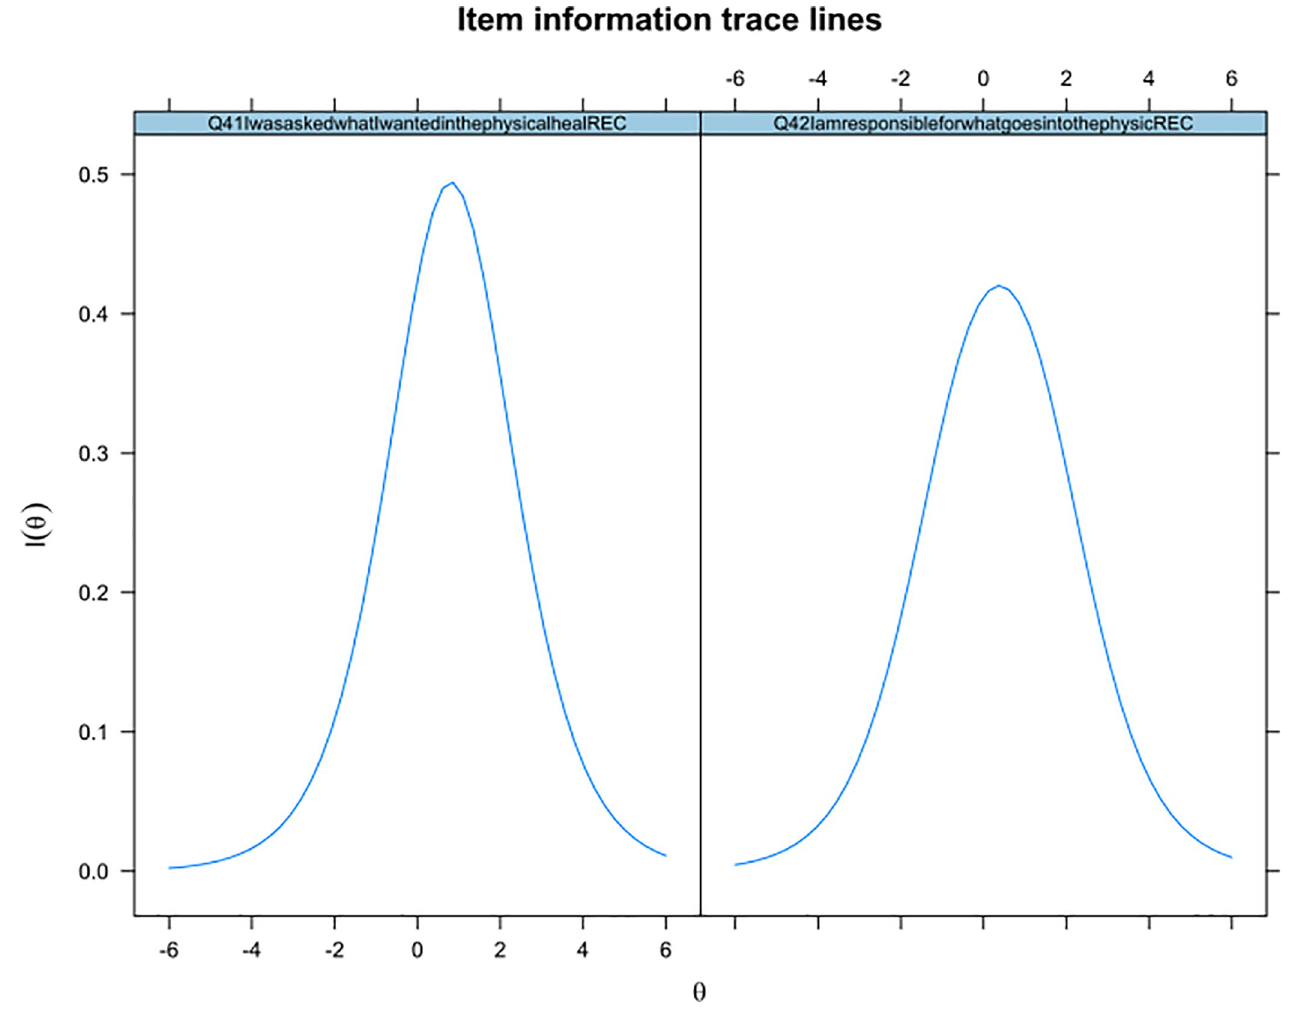
Fig 1. Comparison of item information curves for locally dependent